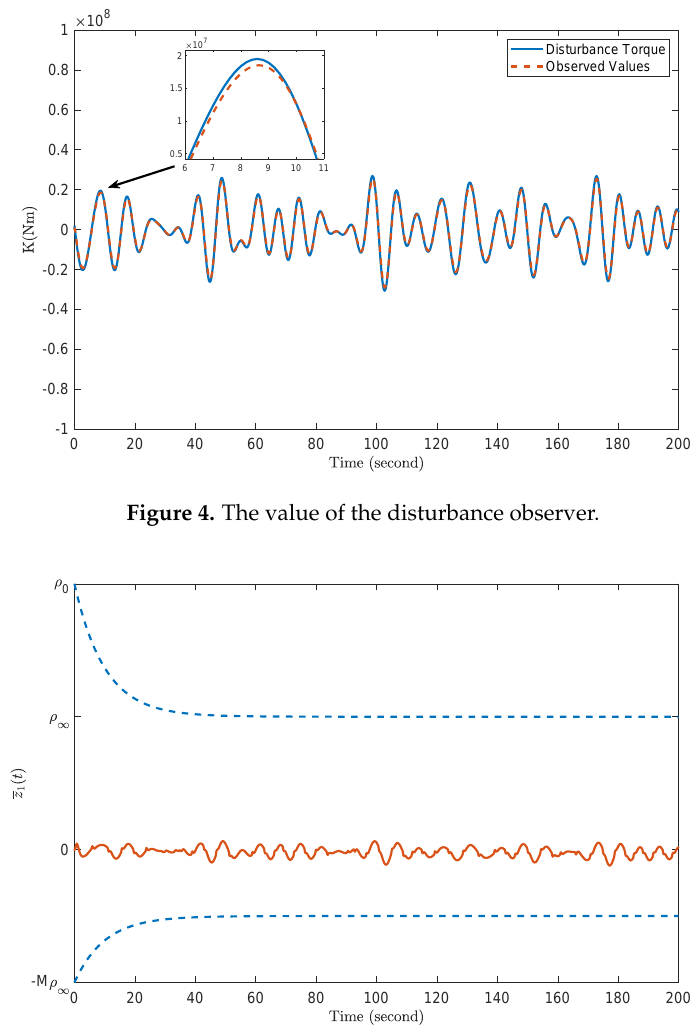
Figure 5. The time response of the compensated tracking error ¯ z 1